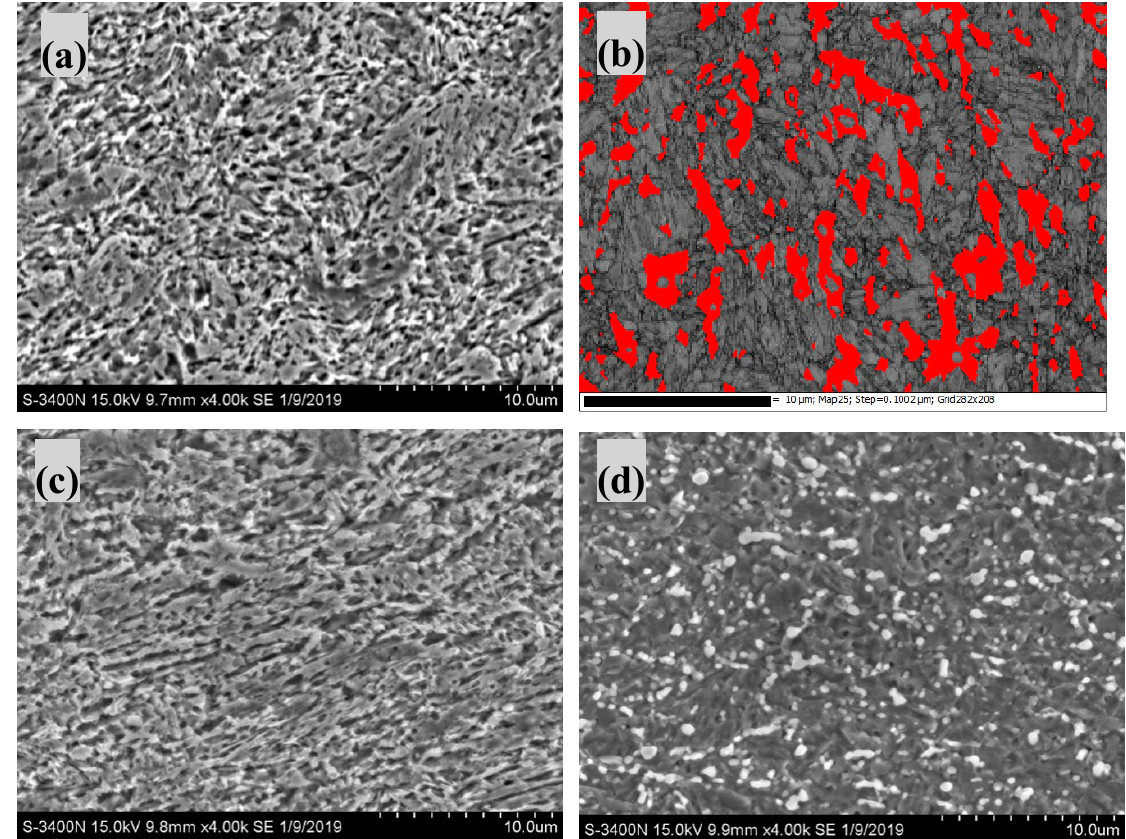
Figure 3. SEM micrographs of single-pass friction stir processed (FSPed) 420 (FSP250): ( a ) advancing side (AS); ( b ) electron backscatter diffraction (EBSD) band contrast imposed by phase maps (the red phase is austenite) at the AS; ( c ) center (C) ; ( d ) retreating side (RS).